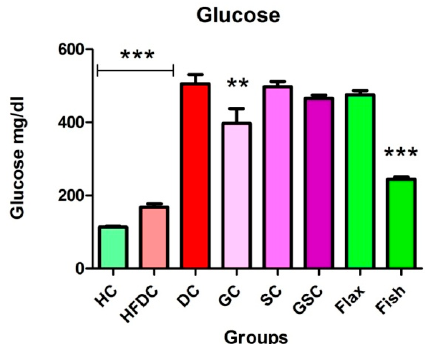
Figure 4. Fish oil intervention lowered serum glucose Results are represented as Mean ± SE (n = 6 for each group). ** p ≤ 0.01 and *** p ≤ 0.001, when compared with the DC group (Dunnett’s Multiple